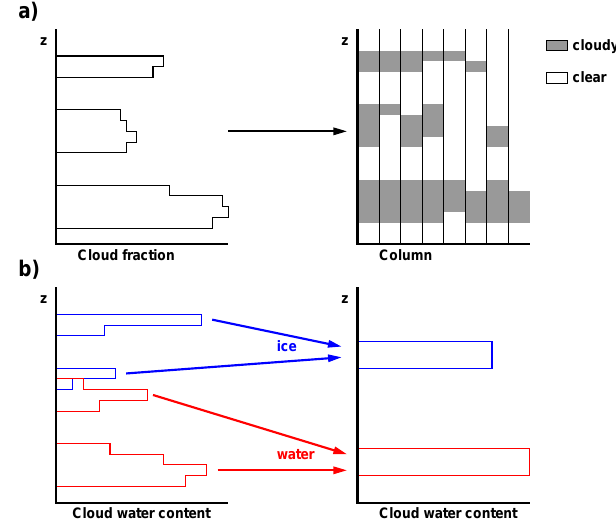
Fig. 3. Simplifications made to the cloud structure in the SEVIRI simulator: a) each model grid cell is divided into subcolumns; in each subcolumn, a model layer that has a non-zero cloud fraction is either completely cloudy or completely clear following the stochas- tic method of R¨ais¨anen et al. (2004); b) in each subcolumn all the ice is put into a single layer at 5-6 km, while all the liquid water is put into a single layer at 1-2 km.